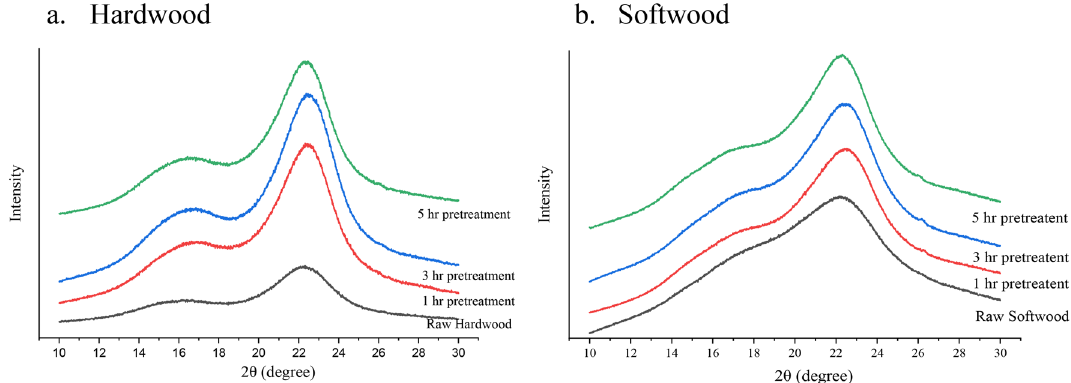
Figure 2. Crystallinity changes between untreated and pretreated biomass.